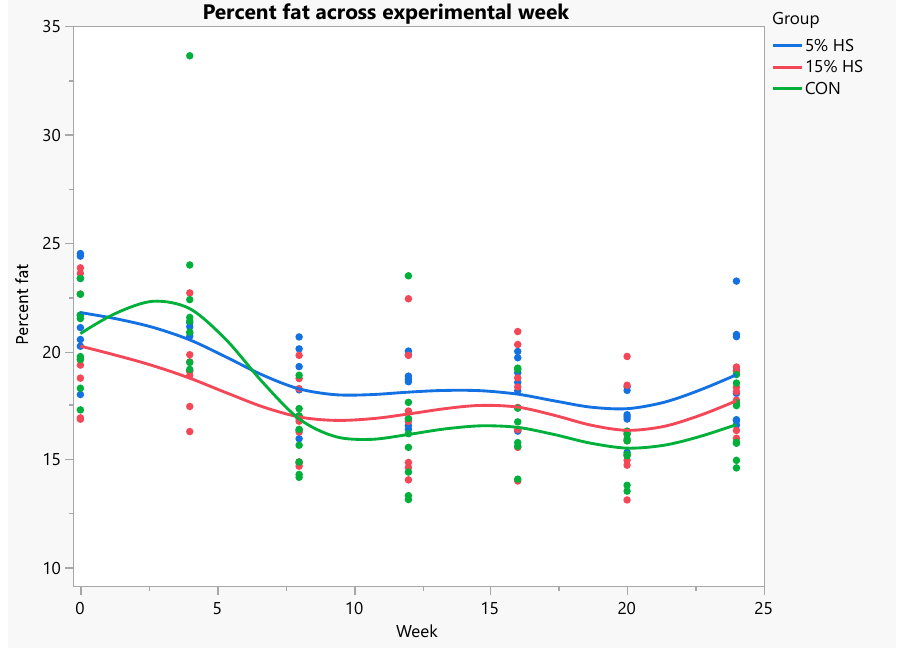
Figure 8. Percent body fat across experimental weeks. Measurements obtained by dual-energy X-ray absorptiometry in live mice. N = 8 per group. Each dot represents an individual mouse; colors represent the experimental diet group. Mixed models with repeated measures showed significantly higher percent fat in the 5% HS versus 15% HS and control diet groups ( p = 0.03). Effect of week, p <